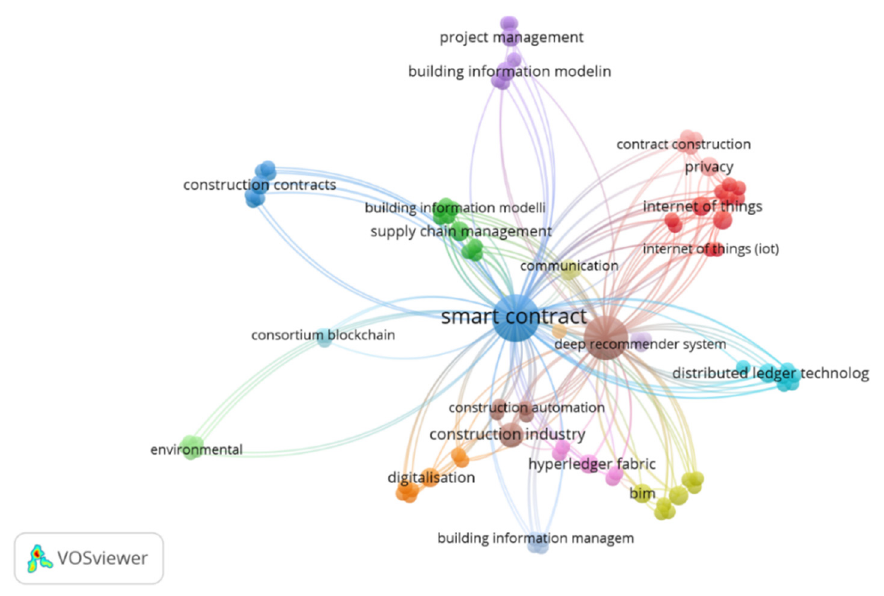
Figure 9. Co-occurrence of keywords.